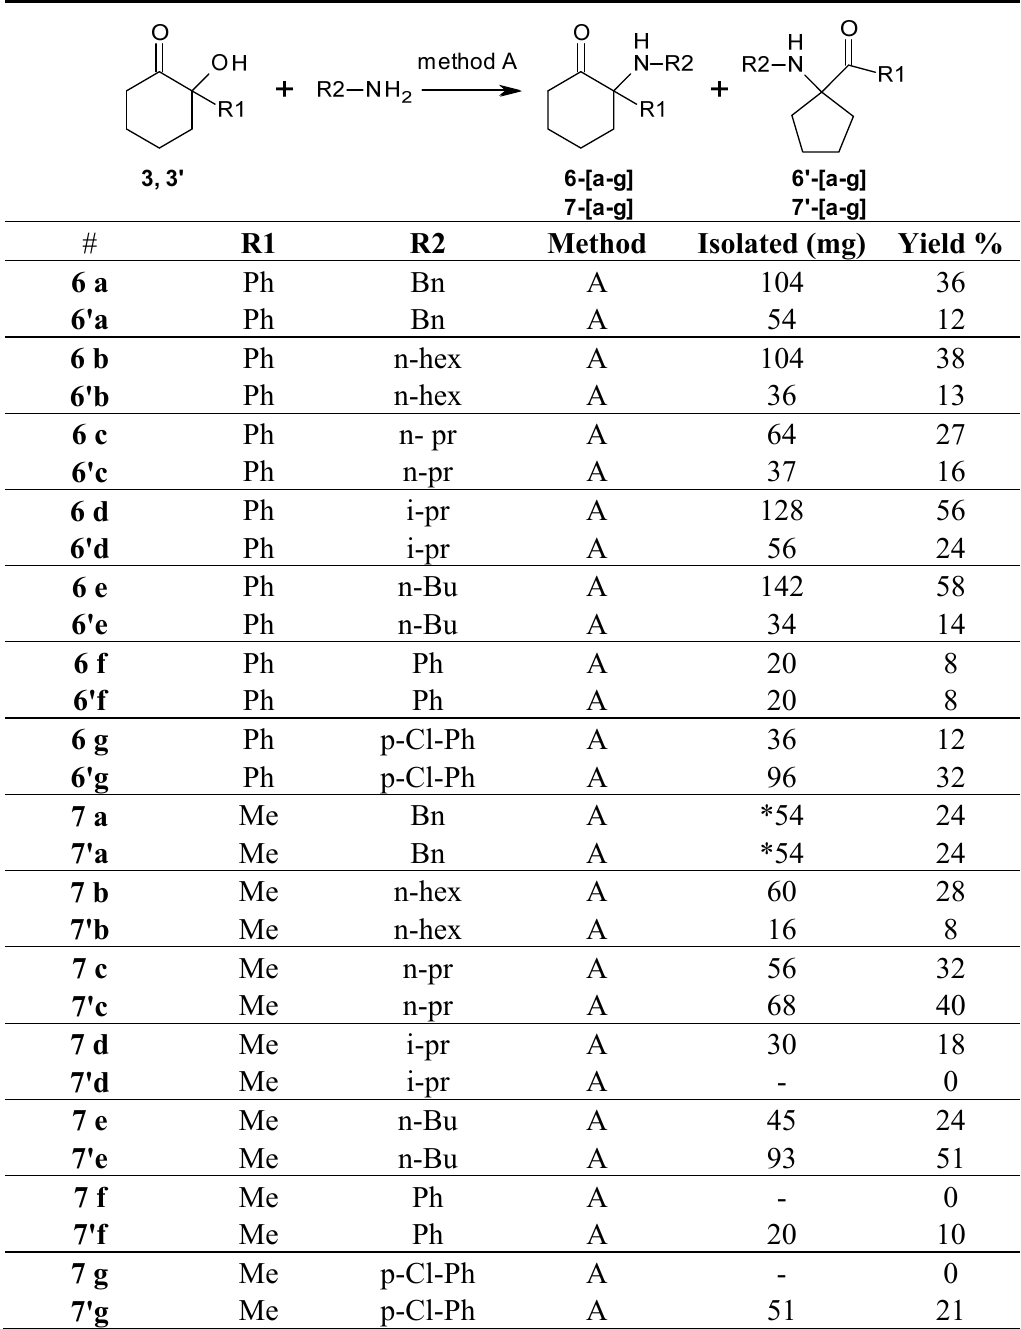
Table 1. Synthesis of six-member ring compounds 6[a–g] , 7[a–g] and five member ring compounds 6'[a–g] , 7'[a–g] analogues of ketamine by thermal rearrangement. method A